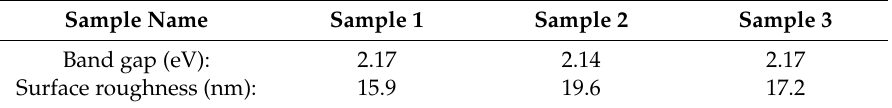
Table 5. Investigated (SE) parameters of Cu 2 O:N thin films.